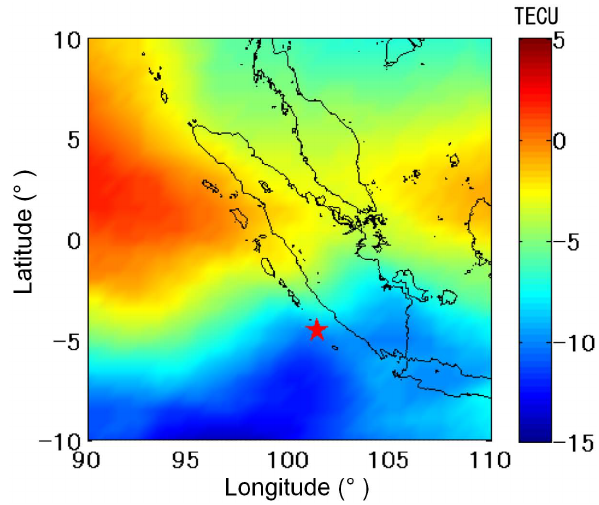
Fig. 7. Spatial distribution of anomalous GIM-TEC* and GPS- TEC* on 9 September 2007. The red star and the solid red line in- dicate the epicenter and magnetic equator, respectively. Pink circles and orange triangles indicate points/stations at which GIM-TEC* and GPS-TEC* values, respectively, produced anomalies. Purple circles and blue triangles indicate positions at which GIM-TEC* and GPS-TEC* values, respectively, did not produce anomalies. Note that GPS-TEC* was calculated directly by data observed from the GPS receiver as well as GIM-TEC*.